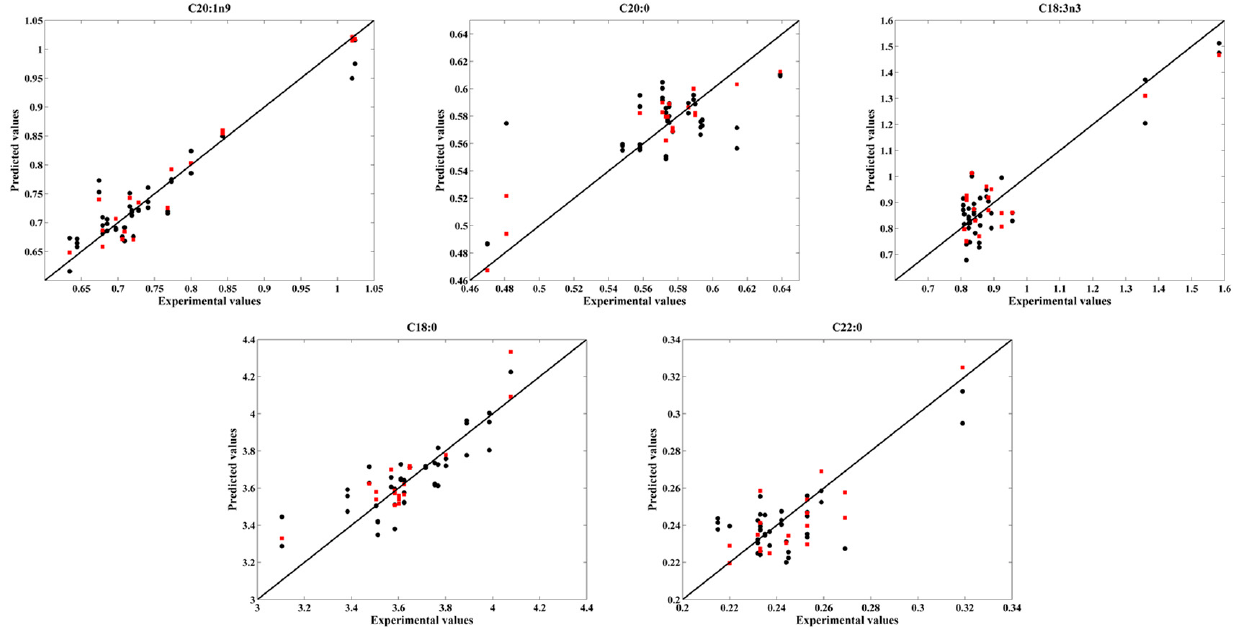
) values obtained for